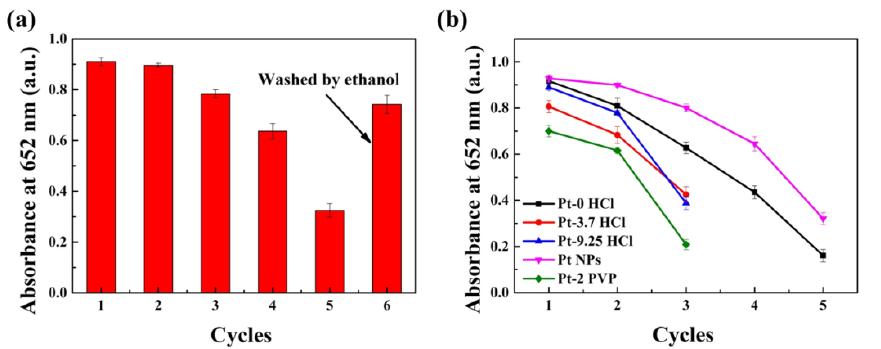
Figure 6. Reusability of ( a ) Pt NPs and ( b ) Pt nanoparticles with different morphologies for catalytically oxidizing TMB.